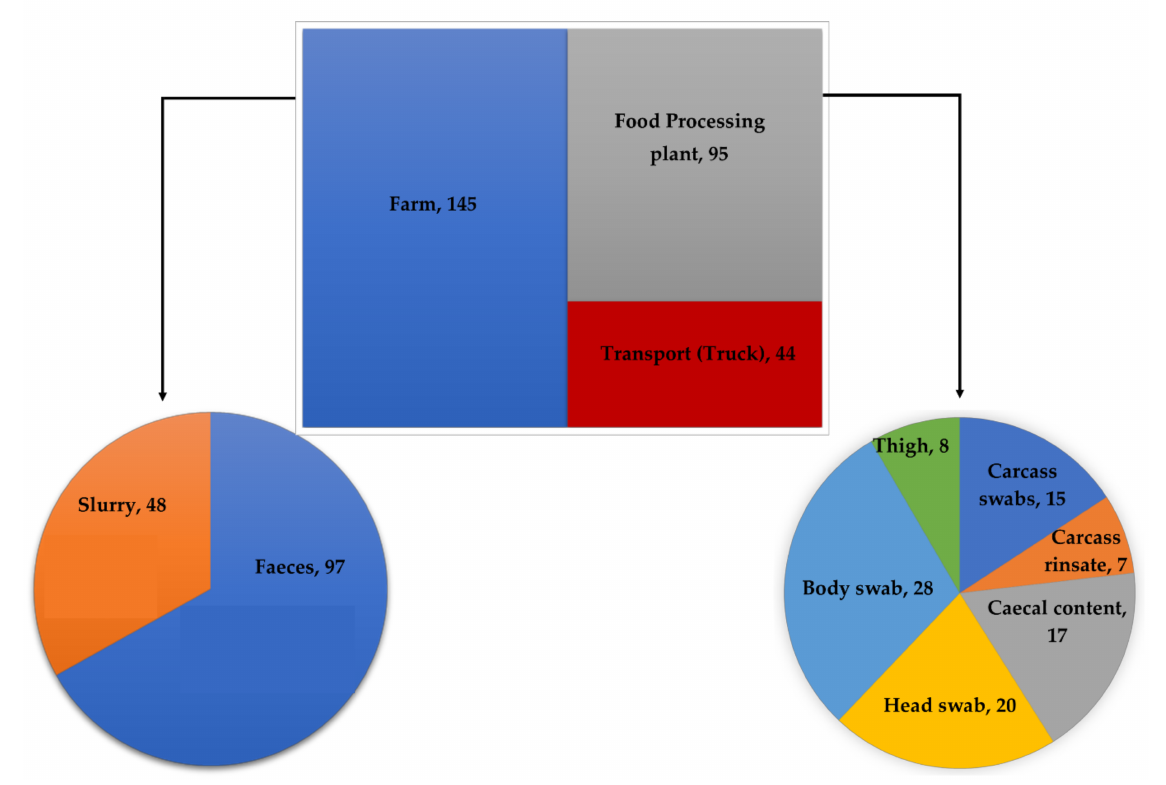
Figure 1. The overall distribution of Enterococcus spp. according to source across the farm-to-fork continuum.